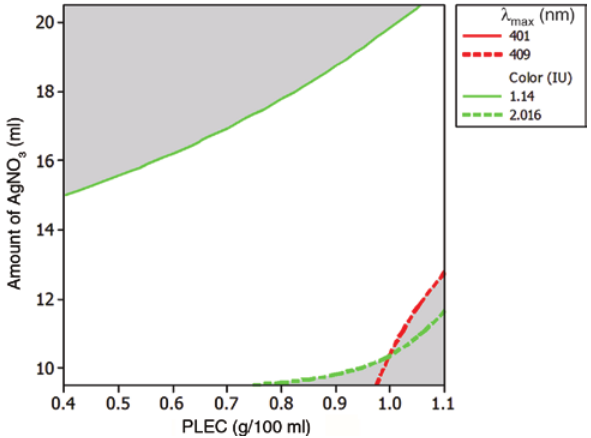
and color of AgNP solution max (ml) and 3